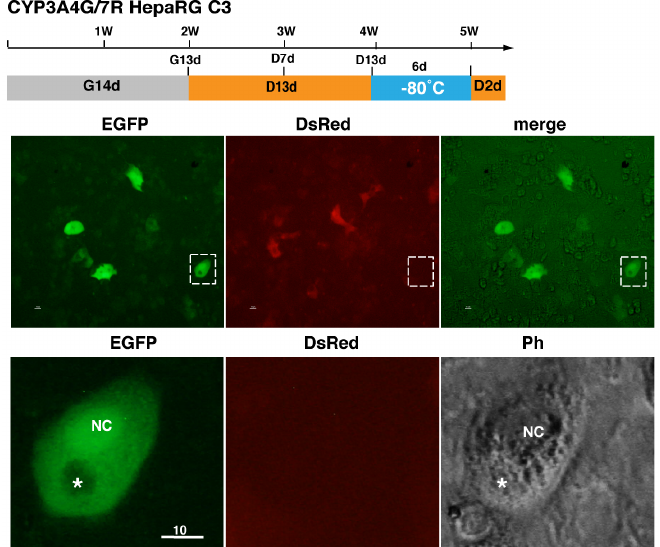
Figure 6. Recovery of frozen EGFP-positive HepaRG cells. HepaRG C3 cells at D13d were frozen period for 6 days at 2 80 u C and then cultured for 2 days. Most cells were viable, including EGFP-positive cells. NC, nucleus; asterisk, an unknown large intracellular